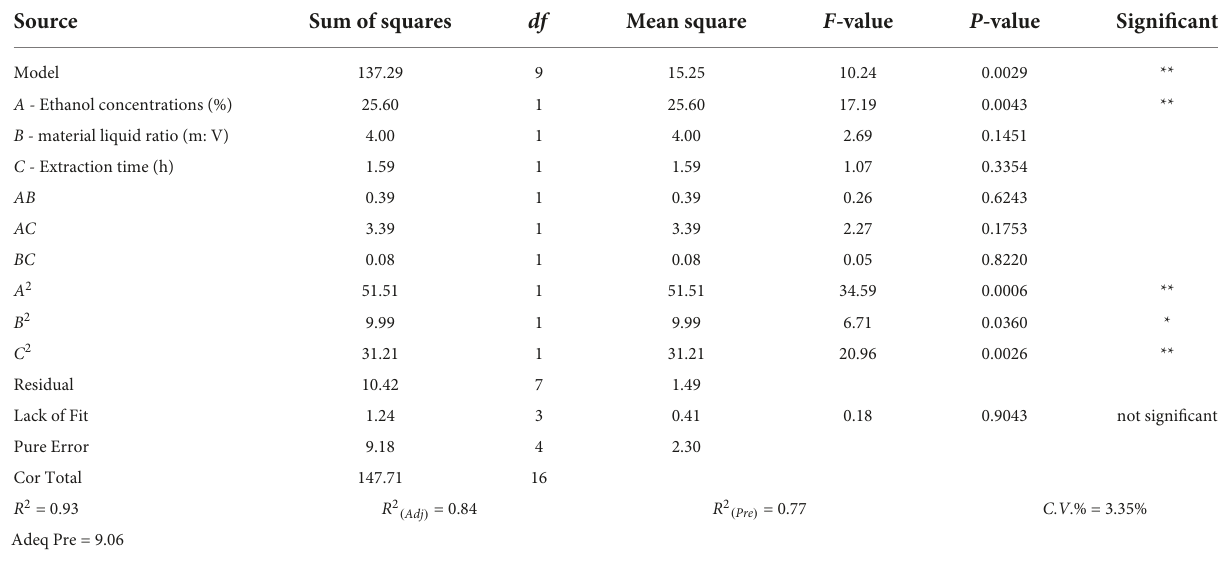
TABLE 2 Variance analysis of the regression model. Source